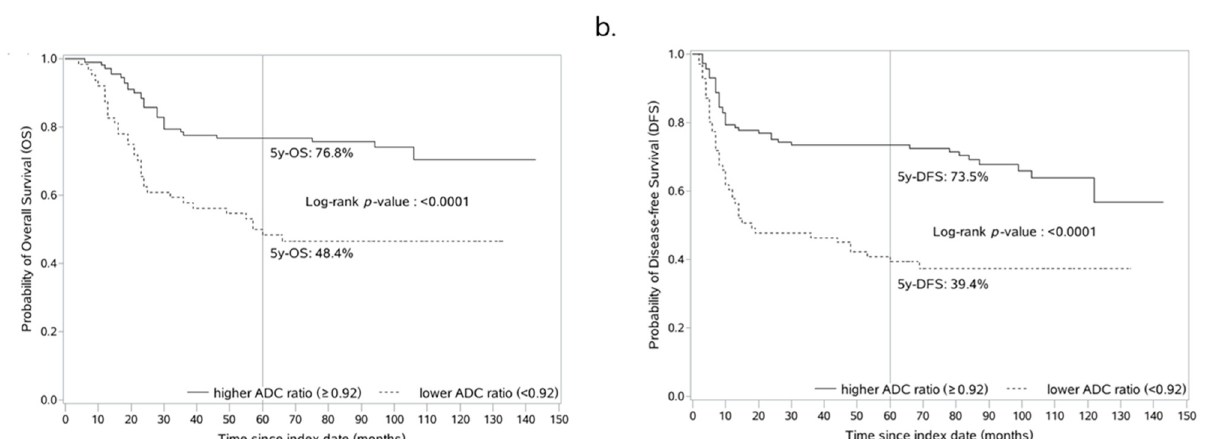
Figure 4. Prognostic model predicts OTSCC outcomes with high sensitivity and specificity. ( a ) Receiver operating characteristic (ROC) curve analysis. ( b ) Calibration plot for disease-free survival. AUC, area under the curve; CI, confidence interval.